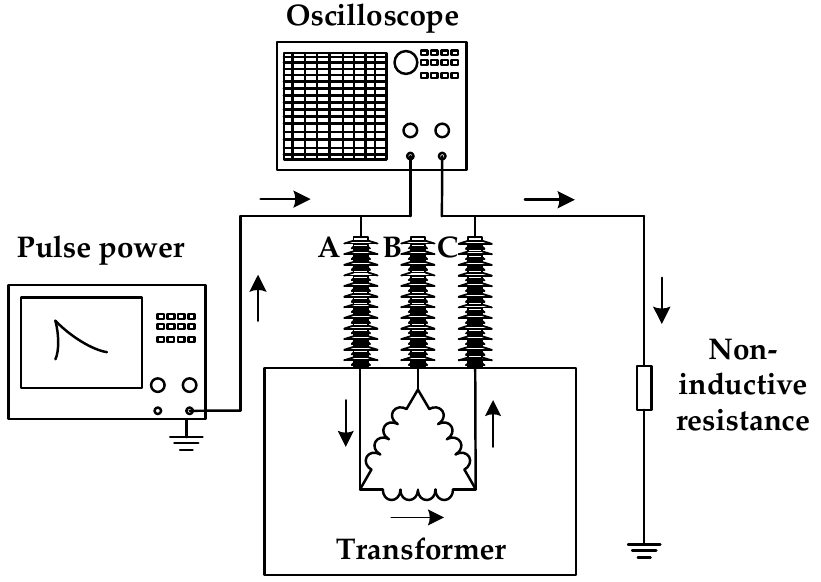
Figure 14. Experimental wiring diagram.